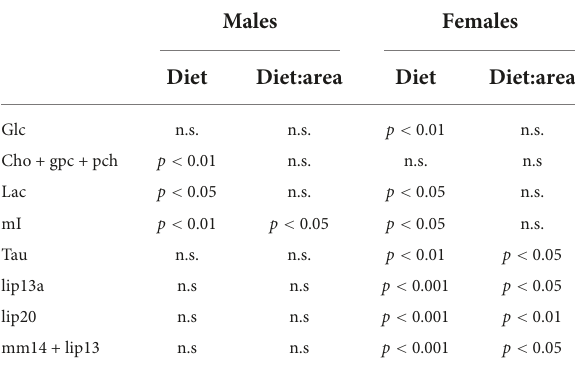
TABLE 2 Results of the type III Anova tests of the fixed effects (diet and diet*area) on the HRMAS data, for male and female